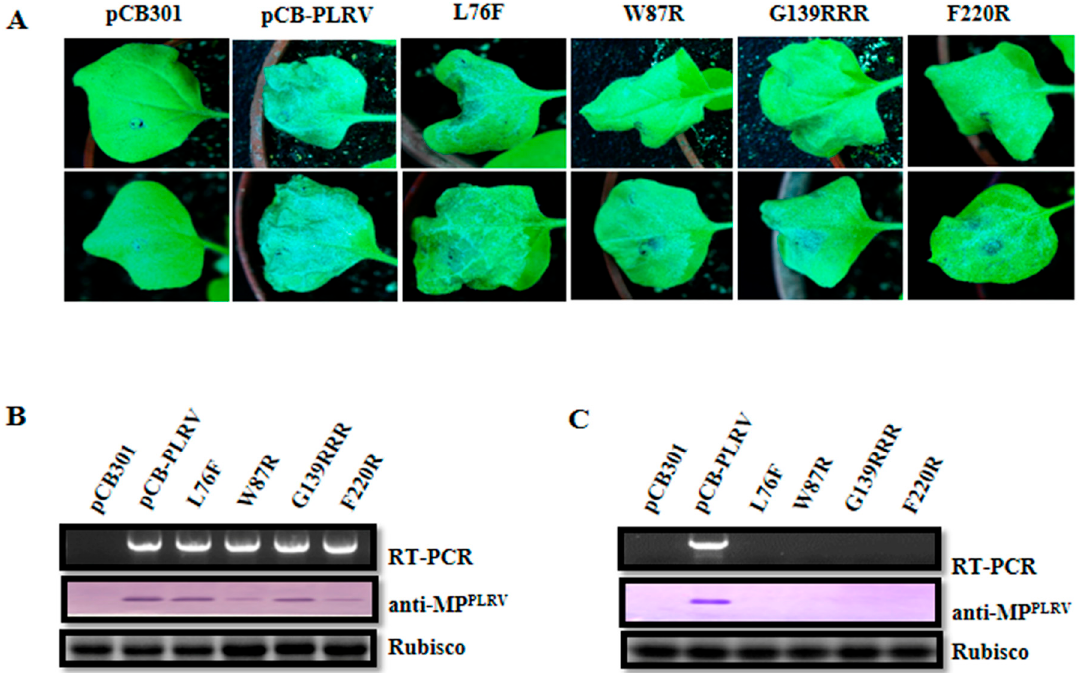
Figure 4. Infectivity analysis of the VSR defective mutants in F-box-like motif, G139/W140/G141-like motif, and the C-terminal conserved region derived from the full-length infectious cDNA clone of PLRV (pCB-PLRV) in N. benthamiana . ( A ) Symptoms on N. benthamiana leaves agroinfiltrated with pCB empty vector (negative control), wild-type pCB-PLRV (positive control) and mutants pCB-PL-L76F, pCB-PL-W87R, pCB-PL-G139RRR, and pCB-PL-F220R respectively, at 7 dpi. ( B ) Assessment of the viral RNA and protein accumulation in N. benthamiana leaves inoculated with pCB-PLRV mutants at 3 dpi by RT-PCR amplification and western blot analysis. ( C ) Assessment of viral RNA and protein accumulation in systemic leaves of N. benthamiana plants inoculated with pCB-PLRV mutants at 14 dpi by RT-PCR amplification and western blot analysis. The upper panel shows the RT-PCR amplification with PLRV-specific primer pair. The middle panel shows the western blot analysis with the PLRV-MP specific antibody (anti-MP PLRV ). Rubisco stained with Coomassie brilliant blue used as a loading control is shown in the lower